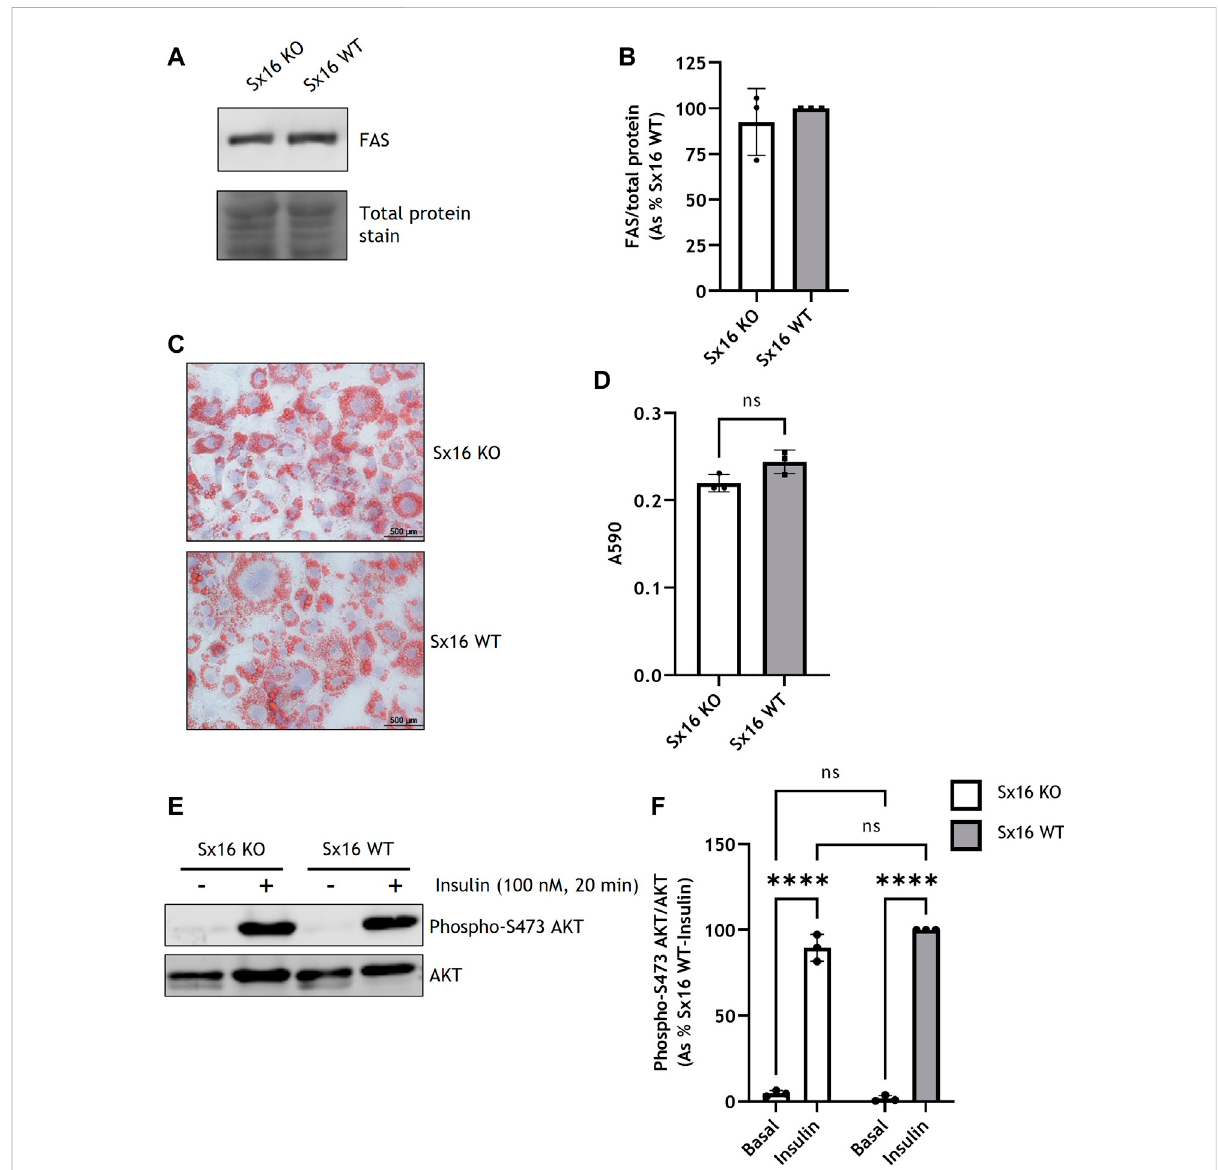
Sx16 knockdown does not affect 3T3-L1 adipogenesis. (A) Lysates prepared from Sx16 KO or WT cells were immunoblotted for fatty acid synthase (FAS) and stained for total protein with Revert ™ total protein stain. (B) Quanti fi cation of FAS levels was determined by comparison with total protein using densitometric analysis. Data shown represent the mean ± SD of three independent experiments. Data is presented as % relative to Sx16 wild type cell lysate, (C) The indicated populations of adipocytes were stained with Oil Red O and Mayers Hematoxylin. Representative images are shown (D) Oil Red O stain was eluted from stained cells and absorbance at 590 nm measured. Data shown represent the mean ± SD of three independent experiments (E) Sx16-KO or WT cells were incubated with or without insulin as indicated and lysates prepared as described. Shown are representative immunoblots of phospho-S471 AKT and total AKT. (F) Quanti fi cation of AKT phosphorylation was determined by comparison with total AKT using densitometric analysis. Data is presented as % relative to insulin stimulated Sx16 wild type from three experiments of this type, each point on the graph is a single biological replicate. **** p < 0.0001 as assessed by two-way